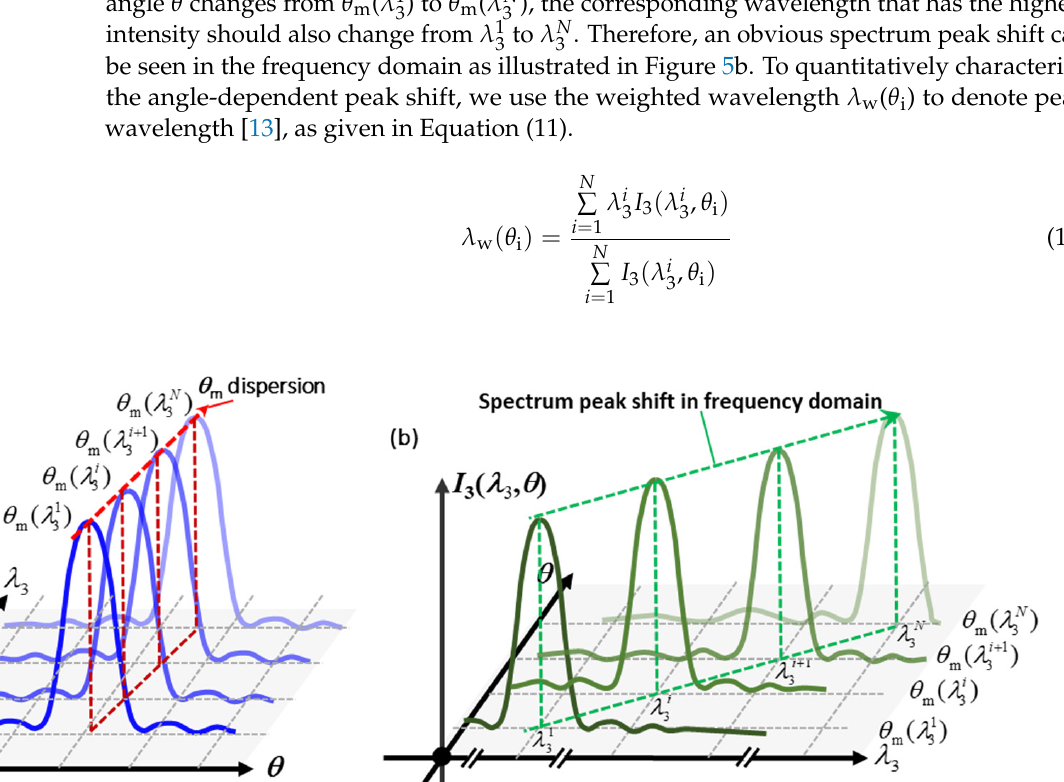
Figure 4. ( a ) The diagram of dispersion-less angle dependence I 3 ( θ ); ( b ) The diagram of dispersive angle dependence I 3 ( θ ).